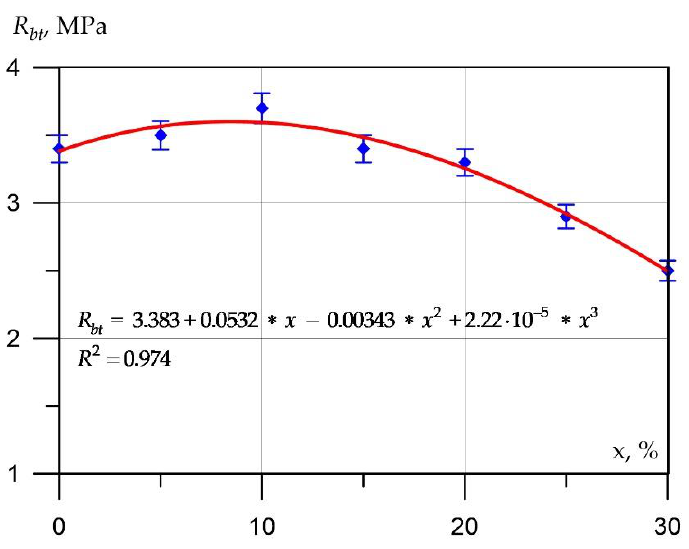
Figure 5. Dependence of the axial tensile strength of concrete on the amount of eggshell powder.